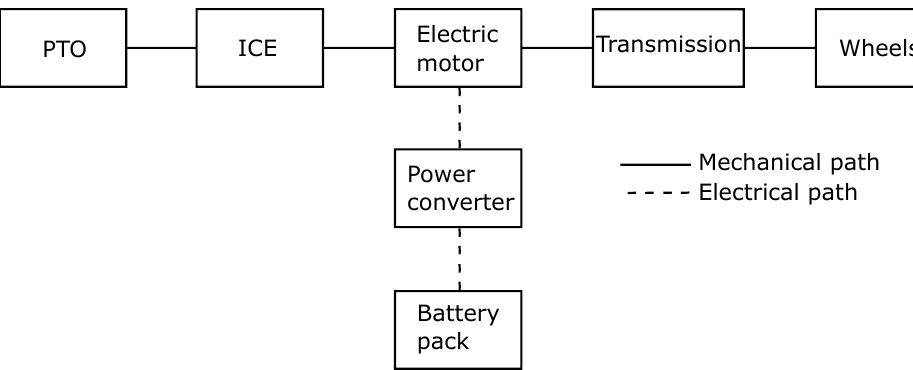
Figure 7. Schematic representation of the parallel hybrid architecture.